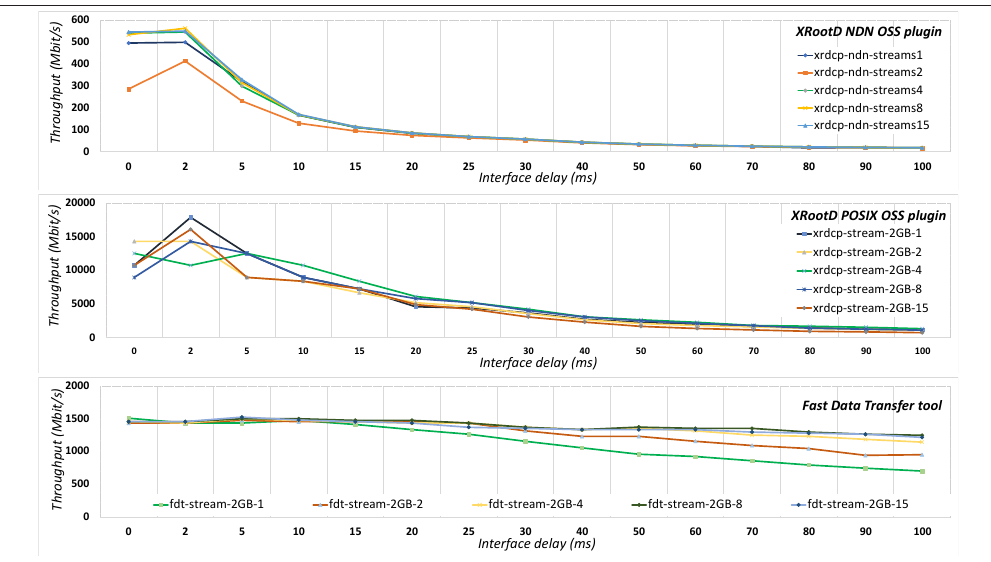
Figure 3: Performance comparison of consumer and producer and standard CMS